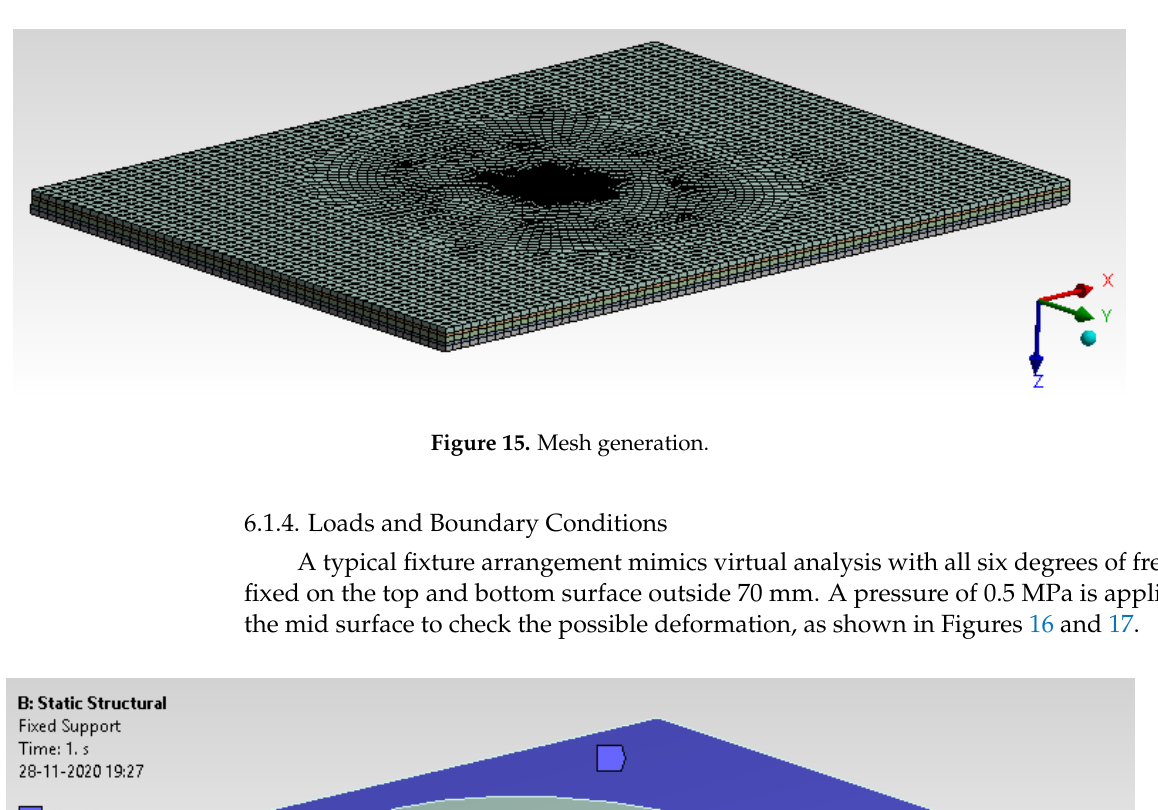
Figure 14. Geometry model.